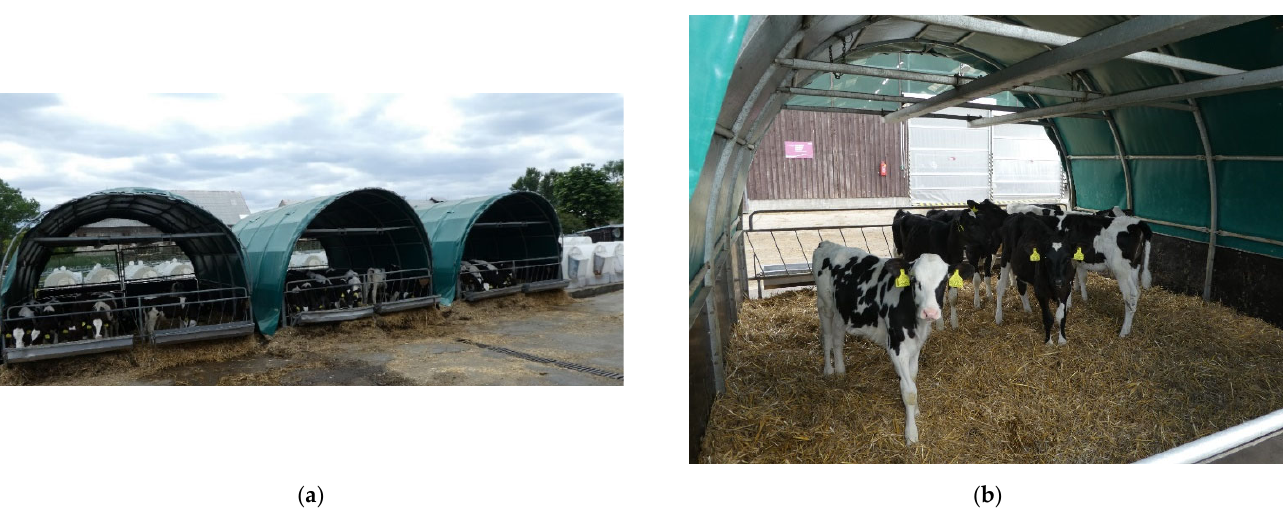
Figure 5. The calf shelters (CaS): ( a ) the group of calf shelters; ( b ) detail of calves inside the shelter. The modernized cowshed for loose housing of dry cows (DC) is a massive brick structure measuring 45.7 m × 7 m. It is traditional solid brick construction, made of solid fired bricks with internal and external plaster, with thickness of 60 cm. The roof is covered only with traditional roof tiles without additional insulation and without ceiling. It is divided into an outdoor feeding passage and a rest area on deep litter, which is located inside the cowshed (Figure 6). Natural ventilation is enabled by a central roof ridge slot, window openings, and four fans. At the time of the measurement, 23 cows were housed in DC.